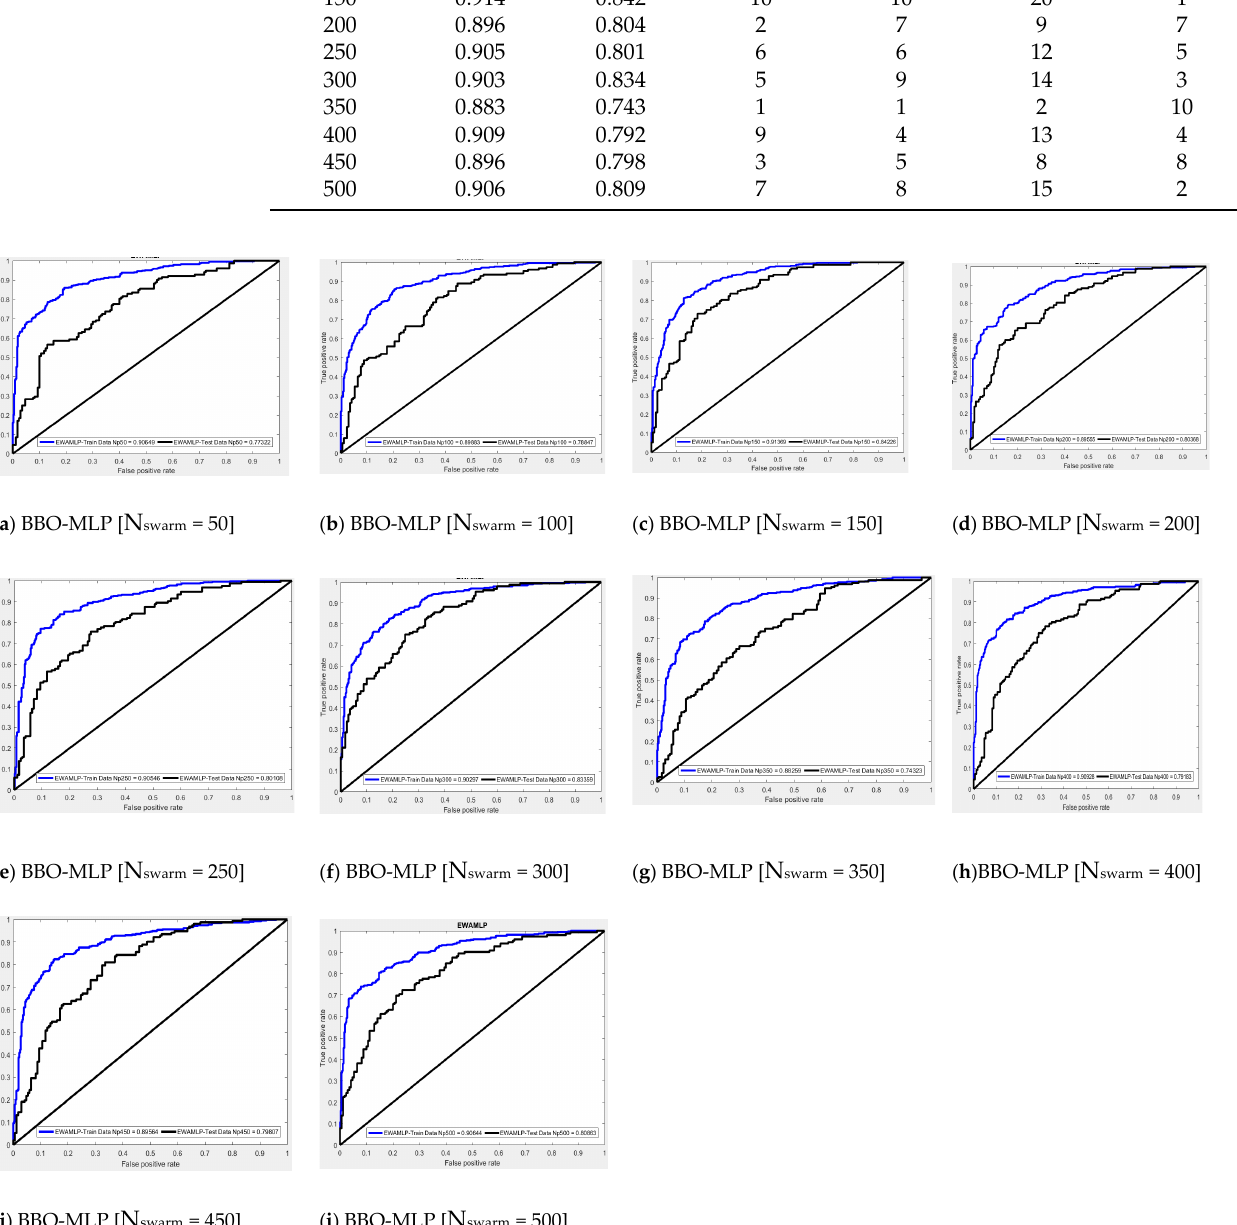
Figure 9. The ROC curves plotted for the (i) training and (ii) testing datasets in BBOMLP algorithm.